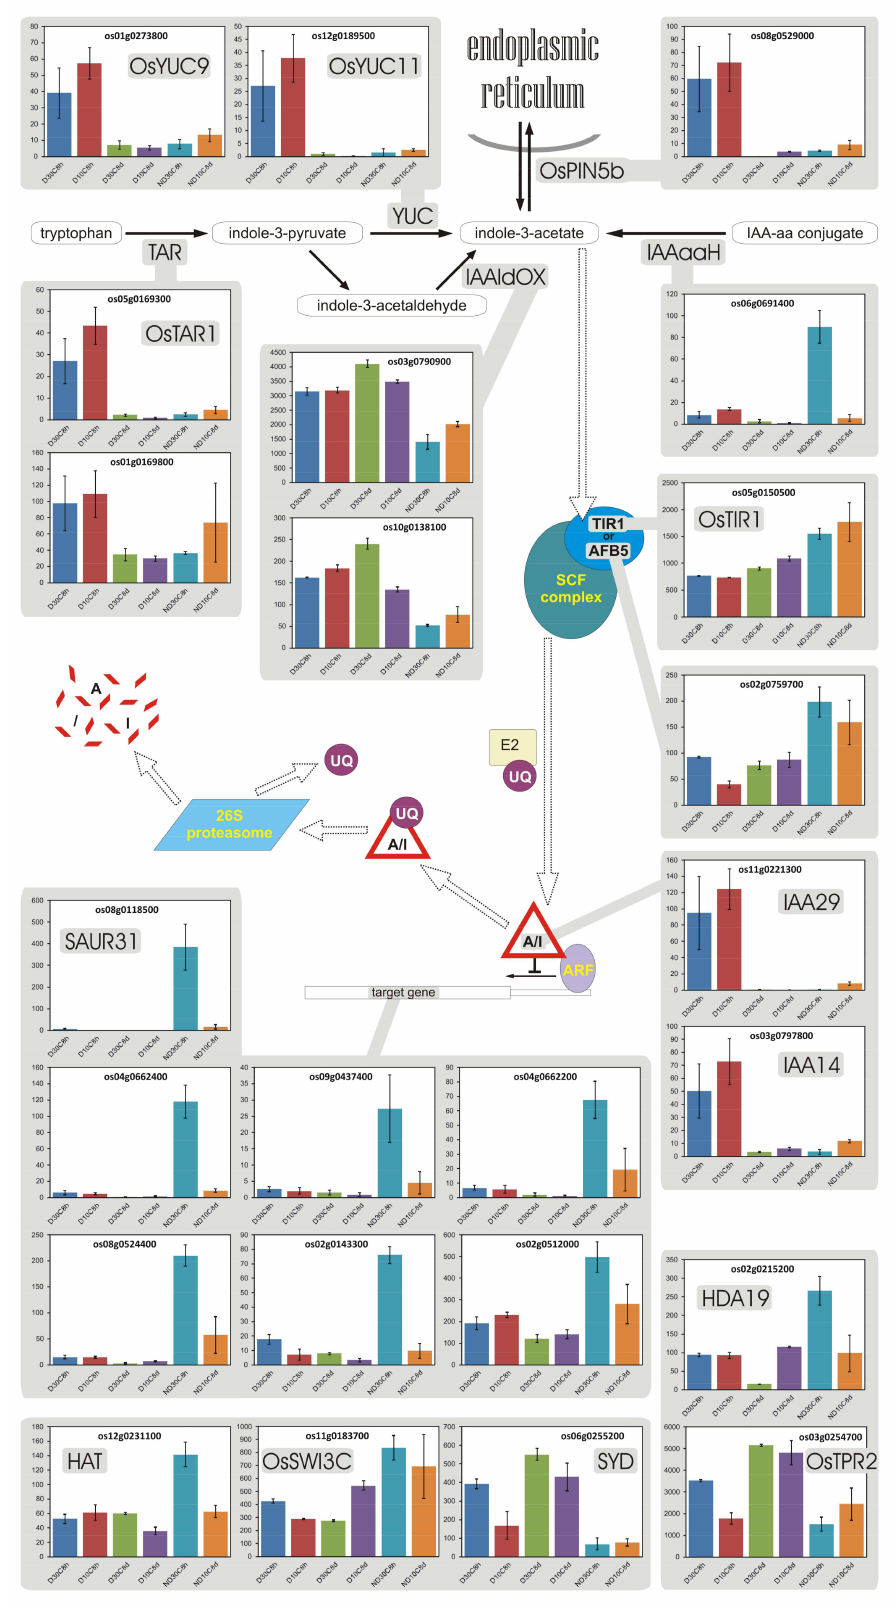
Figure 6. Expression levels (left scale on the y-axis of each plot) of genes involved in auxin